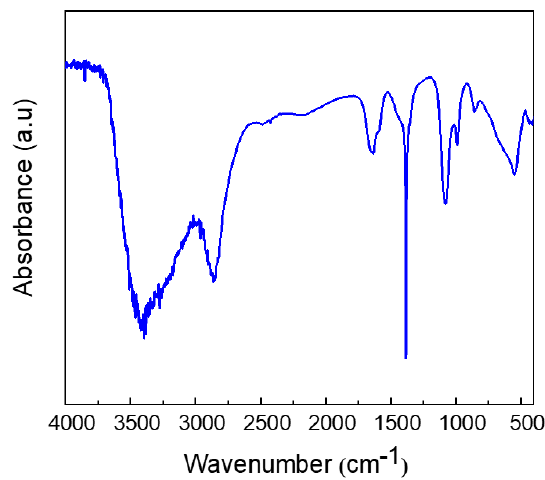
Figure 4. FTIR spectrum of Ag 3 PO 4 .